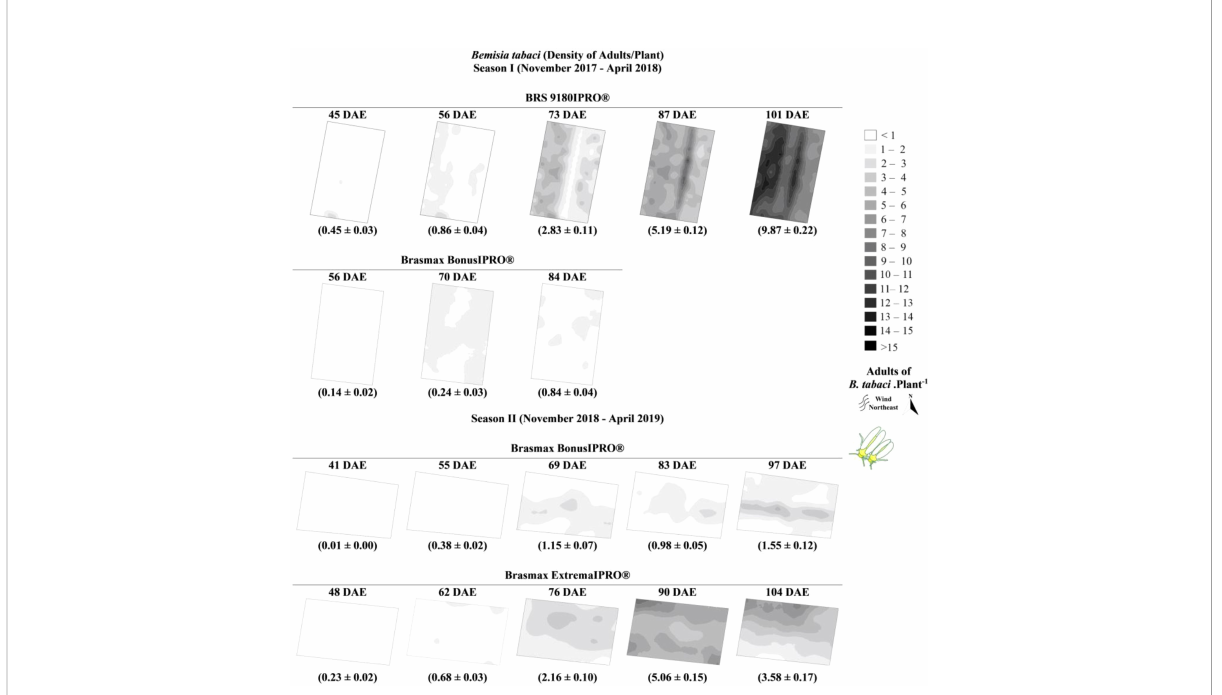
FIGURE 4 Kriging maps for the spatial variability of Bemisia tabaci adults in the Brasmax BonusIPRO ® , BRS 9180IPRO ® and Brasmax ExtremaIPRO ® cultivars in 2017/2018 seasons I and 2018/2019 season